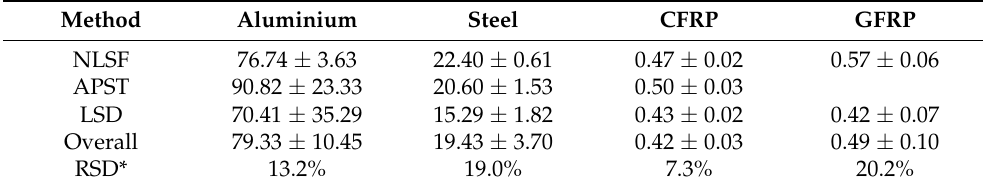
Table 1. Measured thermal diffusivity (mm 2 /s) values with RSD* using the three methods. Method Aluminium